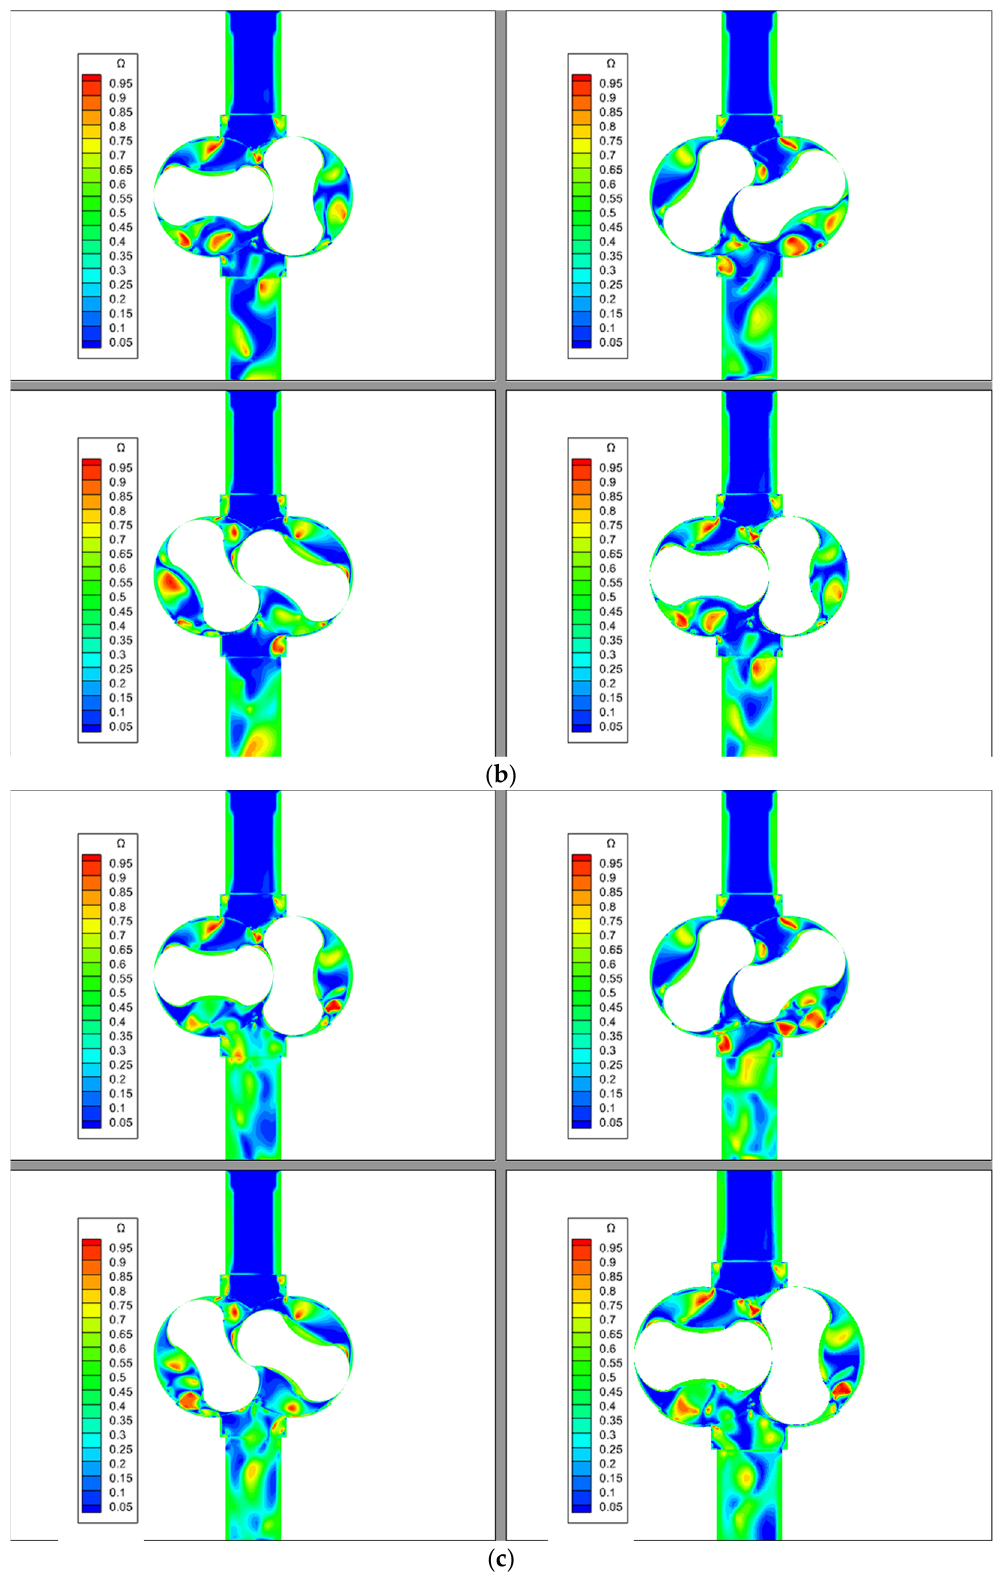
Figure 18. Vortex cloud images at different rotation angles: ( a ) vortex cloud image of the original model; ( b ) vortex cloud image of optimization Model 14; ( c ) vortex cloud image of optimization Model 5.